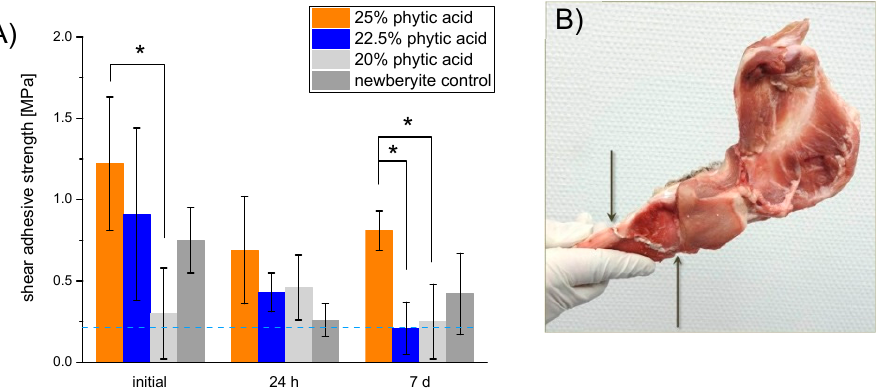
Figure 3. ( A ) Shear strength of cement adhesives made from farringtonite and either 2.0 M phosphoric acid (newberyite reference) respectively 20.0, 22.5 or 25.0% phytic acid initially or after 24 h respectively 7 d hardening in PBS at 37 ◦ C on bovine cortical bone substrates. ( B ) porcine mandible which was manually broken and fixed with 25% phytic acid bone adhesive. The arrows mark the beginning and end of the bonding